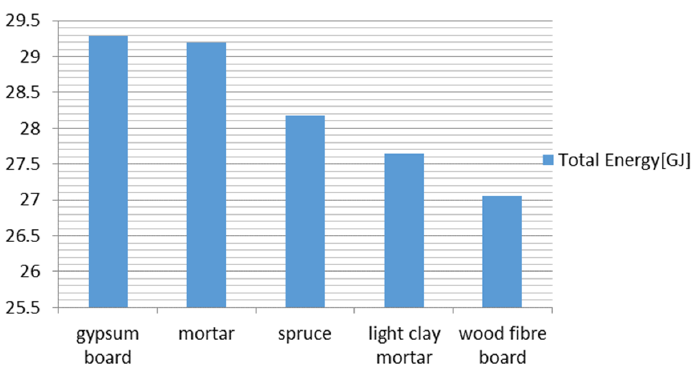
Figure 9. Total energy.